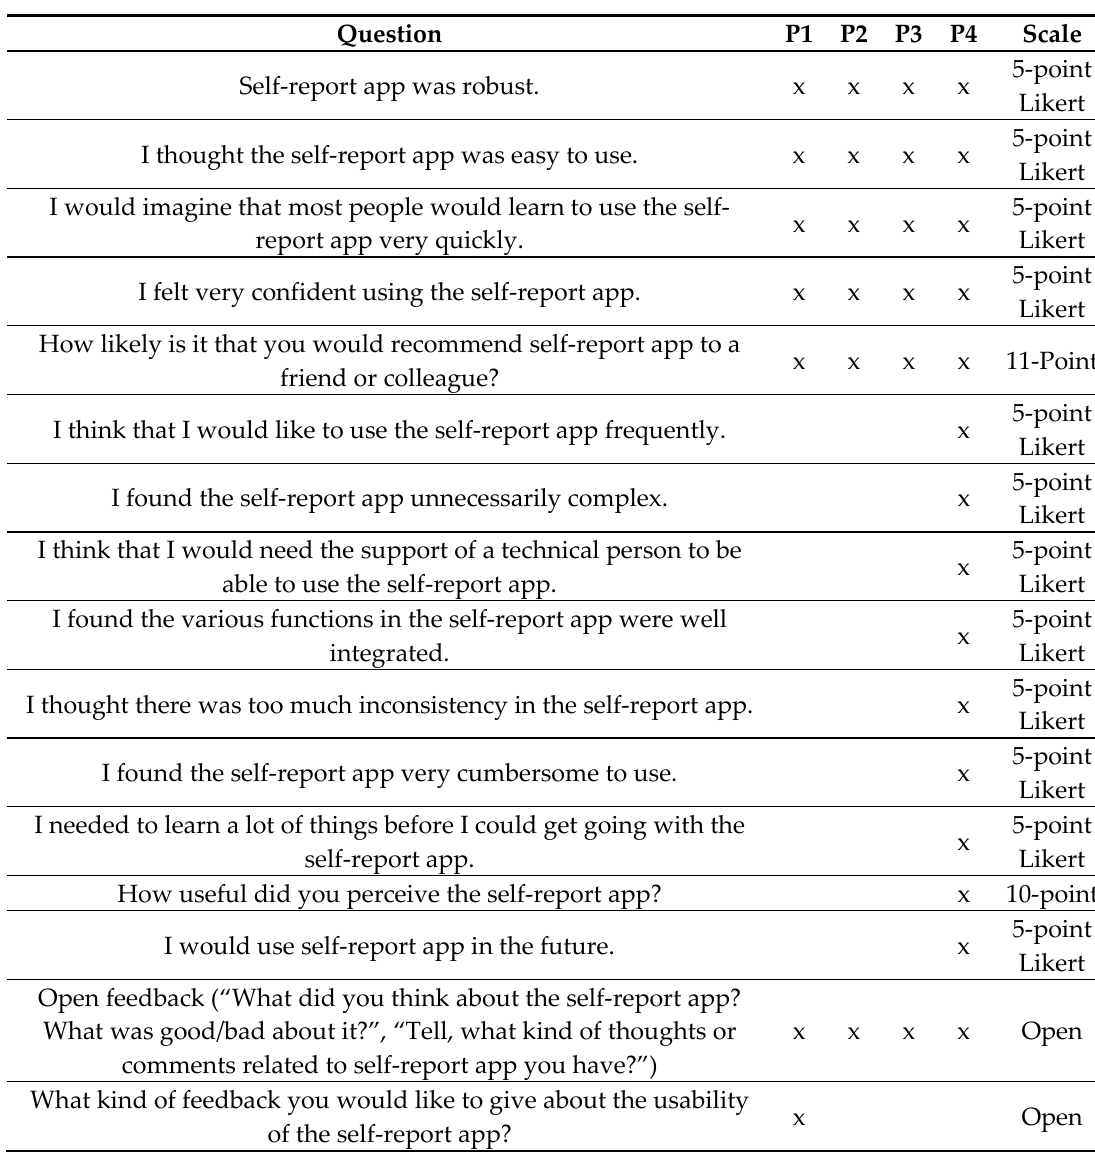
Table 3. User experience questions asked in phases 1–4 (marked as